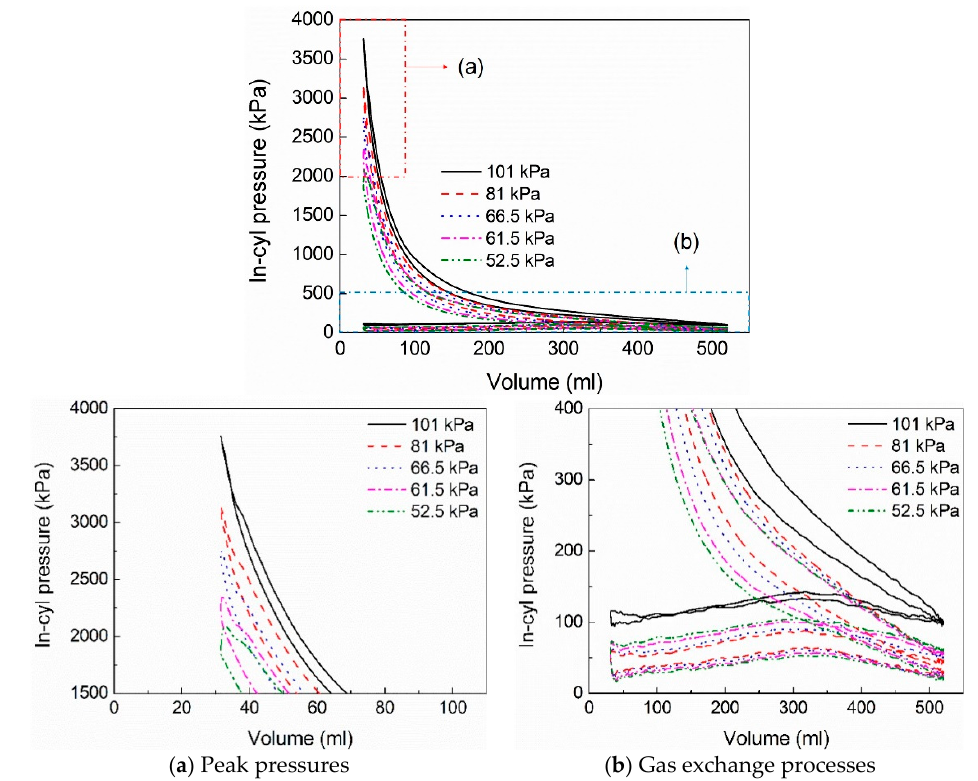
Figure 4. In-cylinder pressure under the various intake manifold air pressures.